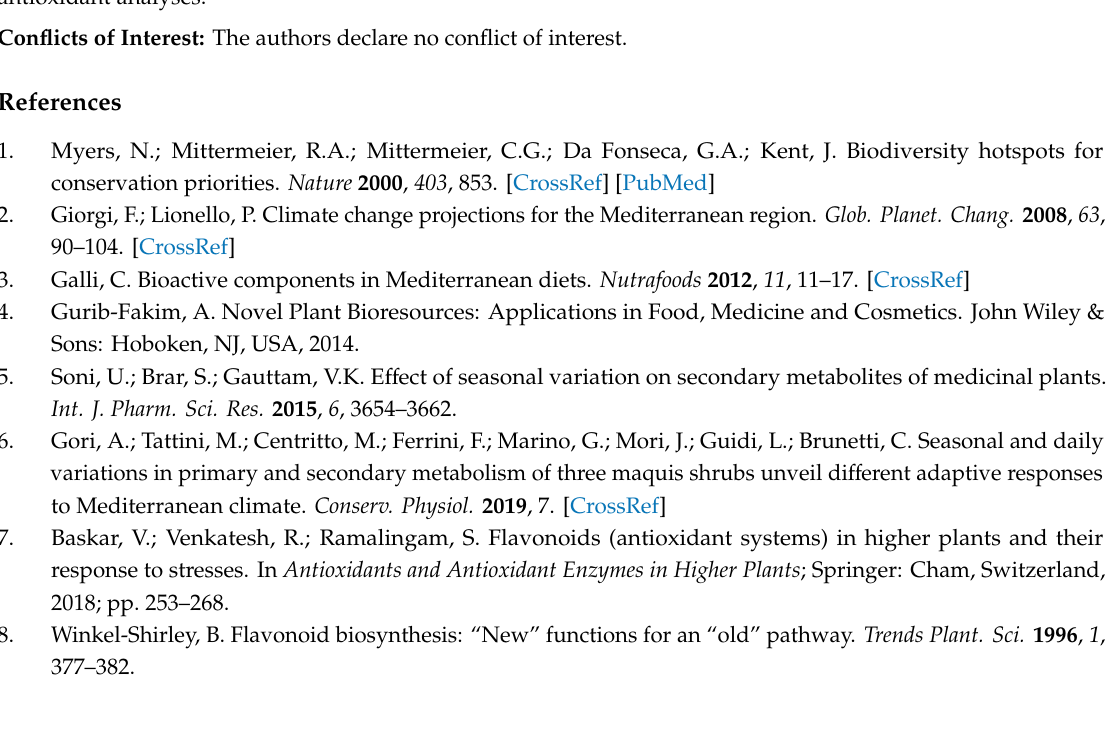
Table S1: Daily and monthly phenolic composition of leaf ethanolic extracts of Phillyrea latifolia in two consecutive years (2014-2015); Table S2: Daily and monthly phenolic composition of leaf ethanolic extracts of Cistus incanus in two consecutive years (2014-2015); Table S3: Daily and monthly phenolic composition of leaf ethanolic extracts of Pistacia lentiscus in two consecutive years (2014-2015). Author Contributions: A.G. and C.B. conceived the experiment; A.G., C.B. and L.B.N. performed the experiment and analyzed the samples; L.B.N. performed statistical analysis and created the figures; All authors have read and agreed to the published version of the